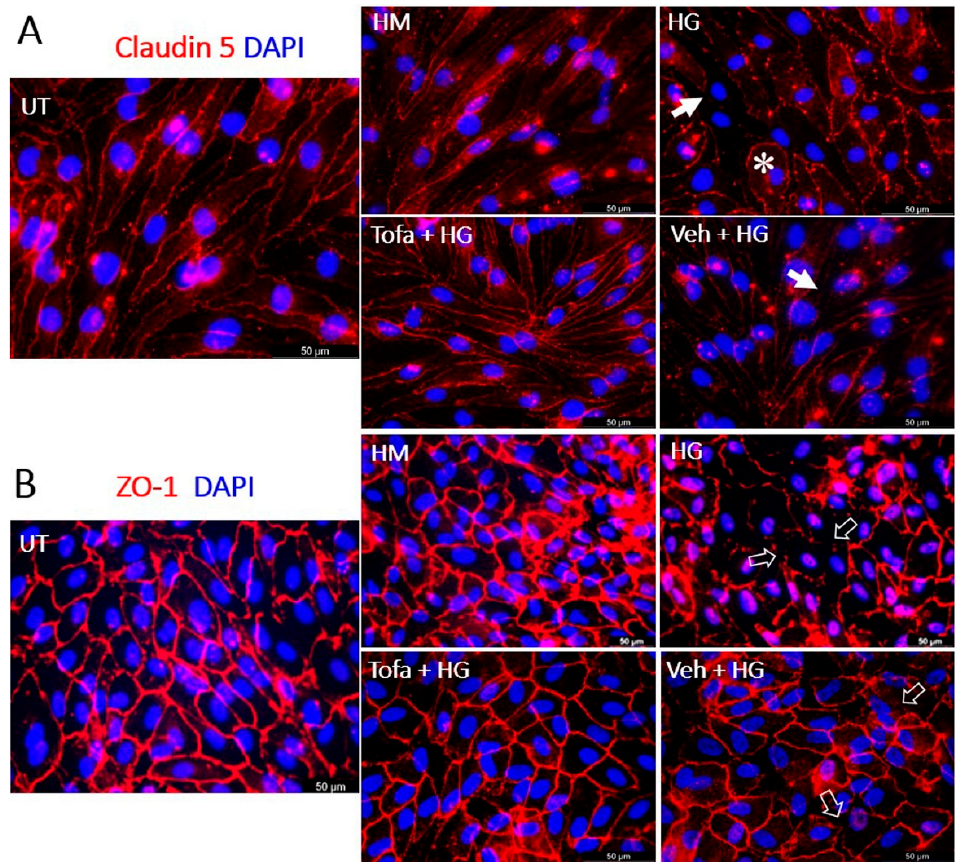
Figure 1. The effect of tofacitinib citrate on high glucose-induced tight junction dysmorphia. UT = untreated control. To mimic hyperglycaemia, cells were treated with physiologically high levels (25 mM) of D-glucose (HG) or D-mannitol (HM). Co-treatment with tofacitinib citrate (Tofa) (4.955 µM) or vehicle control (Veh) were used to investigate the effect of JAK1 inhibition on HG-induced junc- tional protein morphology. Immunostaining for cell nuclei (DAPI in blue) and junctional proteins (red) claudin 5 in bEnd.3 endothelial cells ( A ) and ZO-1 in ARPE-19 RPE cells ( B ). Arrows in ( A ) indicating disruption of claudin 5; asterisk in ( A ) indicating a rounded endothelium. Open arrows in ( B ) indicating ZO-1 disruption in ARPE19 cells. Representative images of n = 3 independent ex- periments.